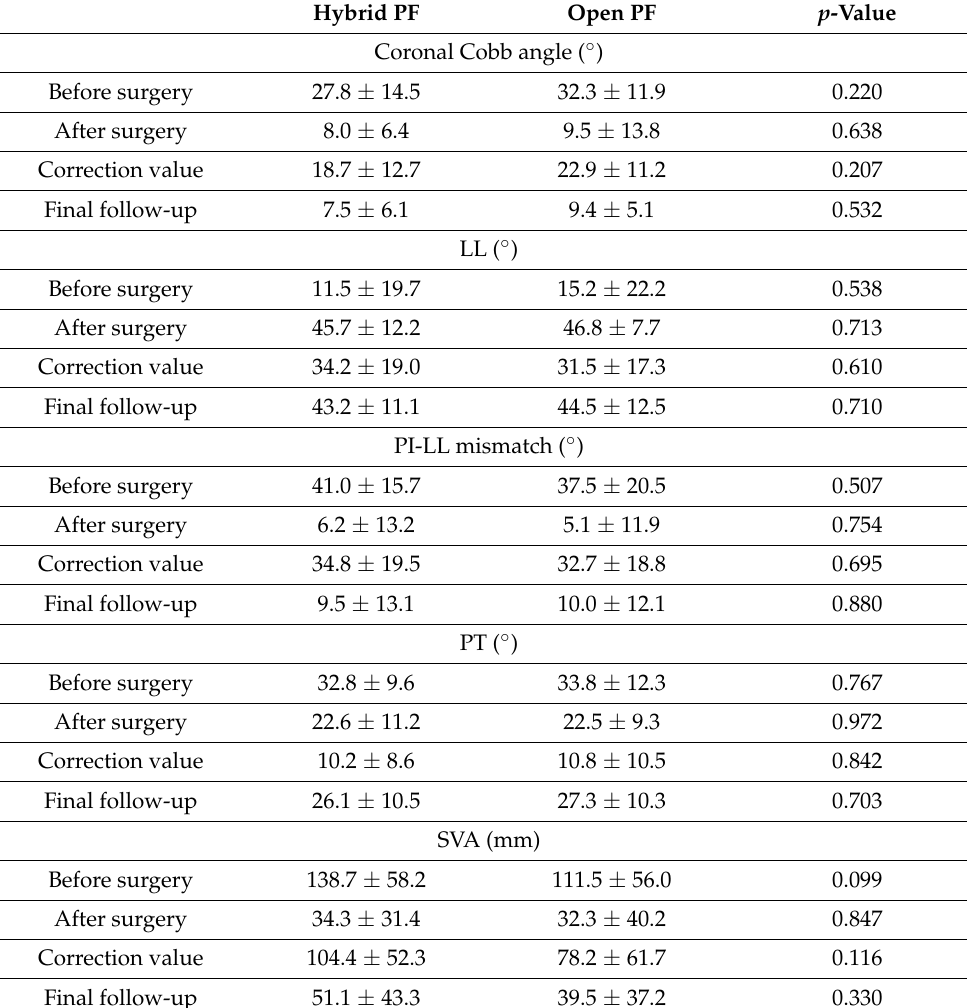
Table 2. Radiographic parameters of the hybrid PF and open PF